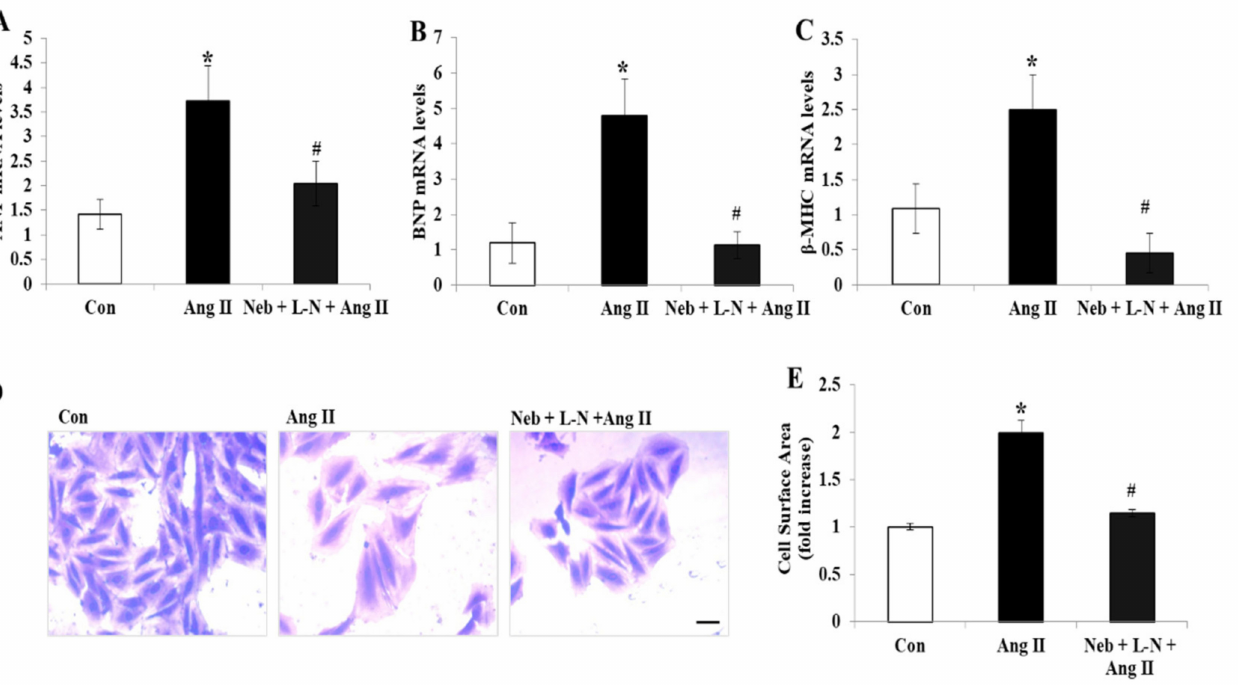
Figure 2. Effects of Neb plus L-N combination on Ang II-induced mRNA expression of cardiac hy- pertrophy genes in H9c2 cardiomyoblasts. Downregulation of mRNA expression of atrial natriuretic peptide (ANP) ( A ), brain natriuretic peptide (BNP) ( B ), and β -myosin heavy chain ( β -MHC) ( C ) by Neb + L-N. ( D ) Images representing morphological changes in H9c2 cells stained with crystal violet; scale bar = 20 µ m. ( E ) Cell surface area was analyzed and is presented as mean (n = 100 cells/group). * p < 0.05 vs. untreated (Con) and # p < 0.05 vs. Ang II. Values are means ± SEM. N ≥ 3–6 for each treatment